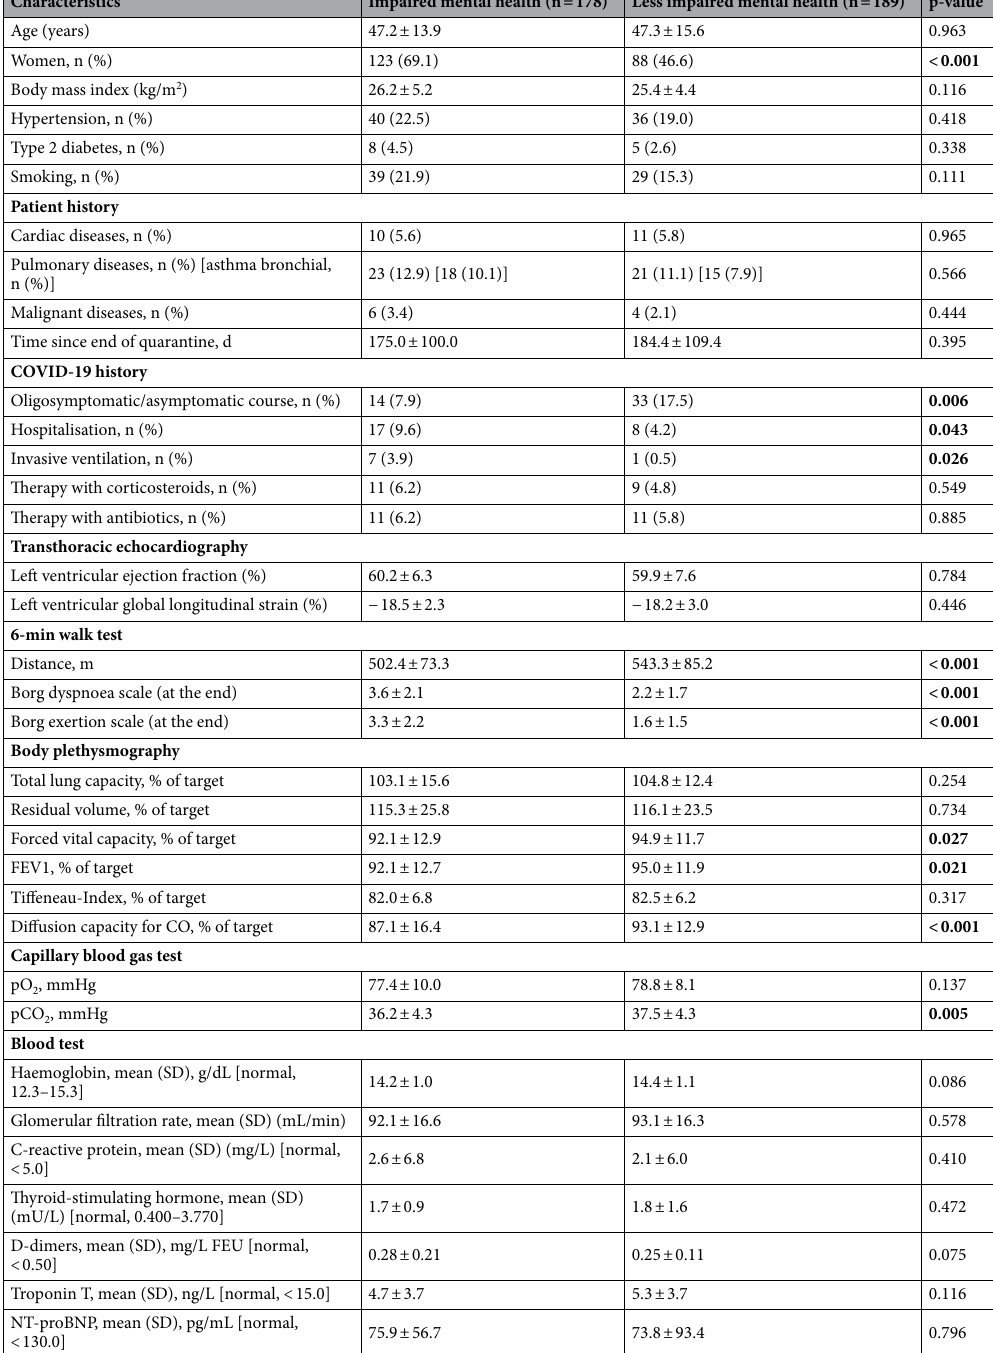
Table 4. Cardiac and pulmonary function depending on the assessment of mental health by SF-36. The lower two quartiles (< 69.1 points) were described as impaired, and the upper two quartiles (> 69.1 points) as less impaired physical health. Continuous variables are expressed as means ± standard deviations. Categorical variables are expressed as numbers (percentages). FEV1 forced expiratory volume in one second, CO